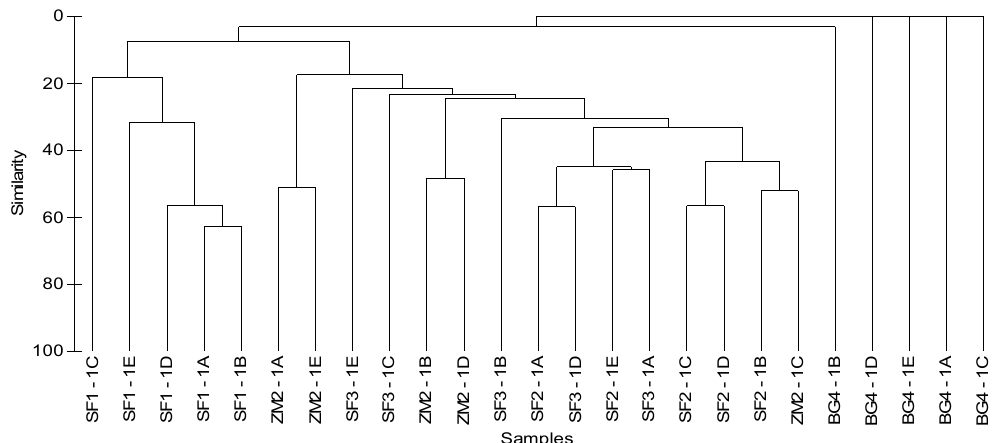
Figure 3. Bray–Curtis similarity dendrogram based on abundance, showing the classification of each station replicates.